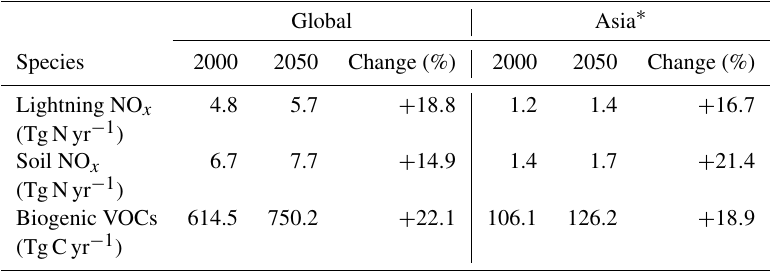
Table 2. Natural emissions of O 3 precursors for the present day (the year 2000) and the future (the year 2050; under the SRES A1B scenario). Global Asia ∗